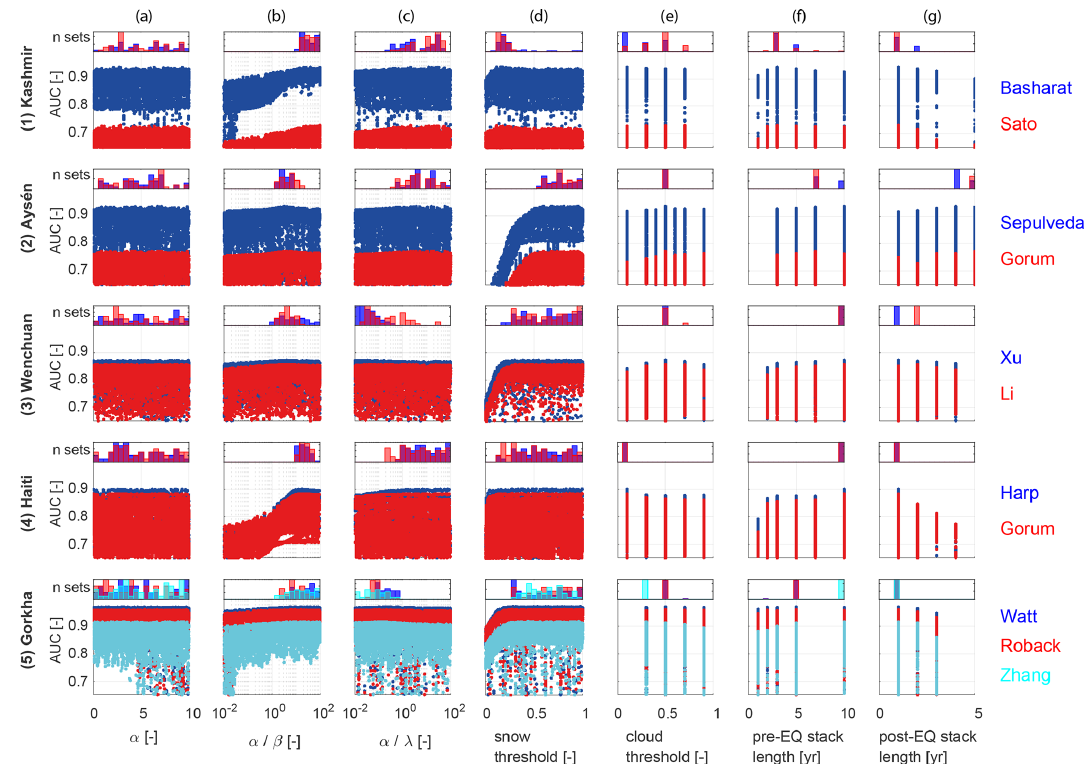
Figure 4. Dotty plots and posterior parameter distributions for the seven tuneable parameters associated with ALDI (columns a – g ) for the five study earthquakes (rows 1–5). Dotty plots show classifier performance evaluated using AUC, the area under the ROC curve. Blue or red colours indicate the inventory used as the check dataset, as shown to the right. Parameter distributions are for the best 100 parameter sets evaluated using the same metric. EQ: